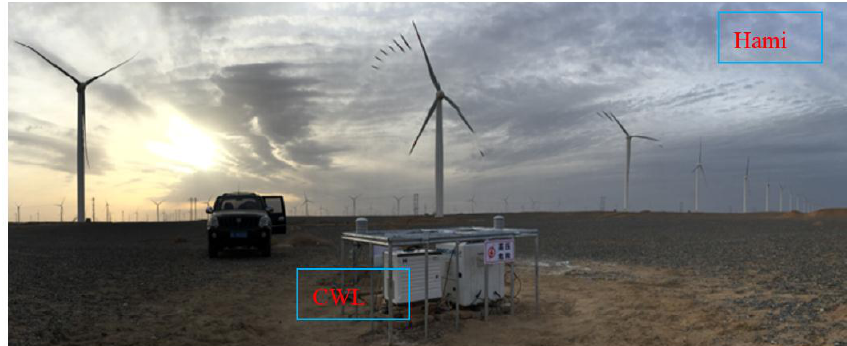
Figure 7. Geographical location and instrument layout.